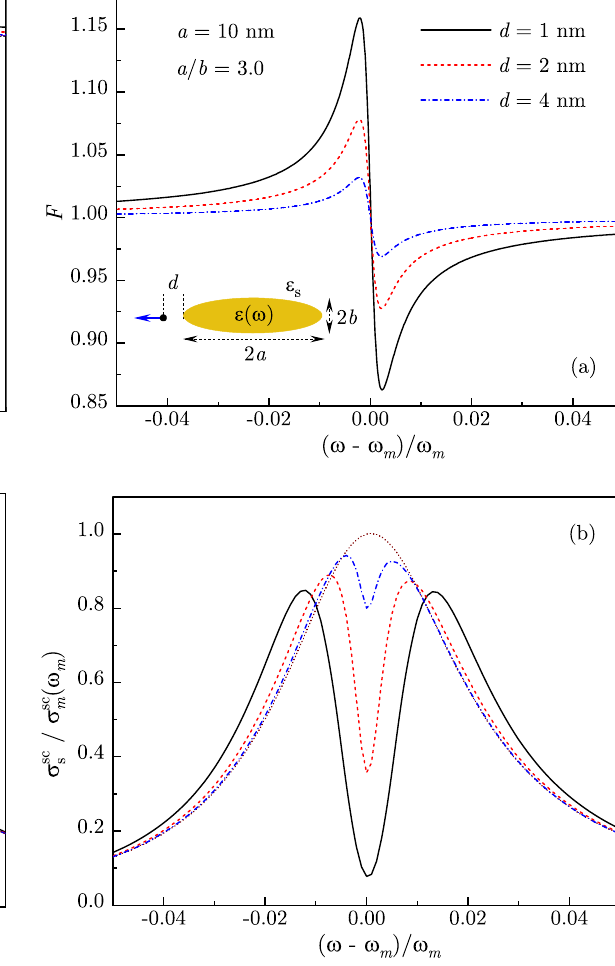
Figure 3: (a) The Fano function F ( 𝜔 ), given by Eq. (31), is shown for a QE near the tip of Au nanorod with aspect ratio a ∕ b = 3 . 0 and length 2 a = 20 nm at distances d = 4, 2, and 1 nm. (b) Normalized scattering cross-section, given by Eq. (36), is shown for the same system parameters. The dotted line is the plasmon band. All curves = 𝜔 . Inset: schematics of a QE situated at a are calculated for 𝜔 e m distance d from the tip of Au nanorod in water for QE dipole moment oriented along the nanorod